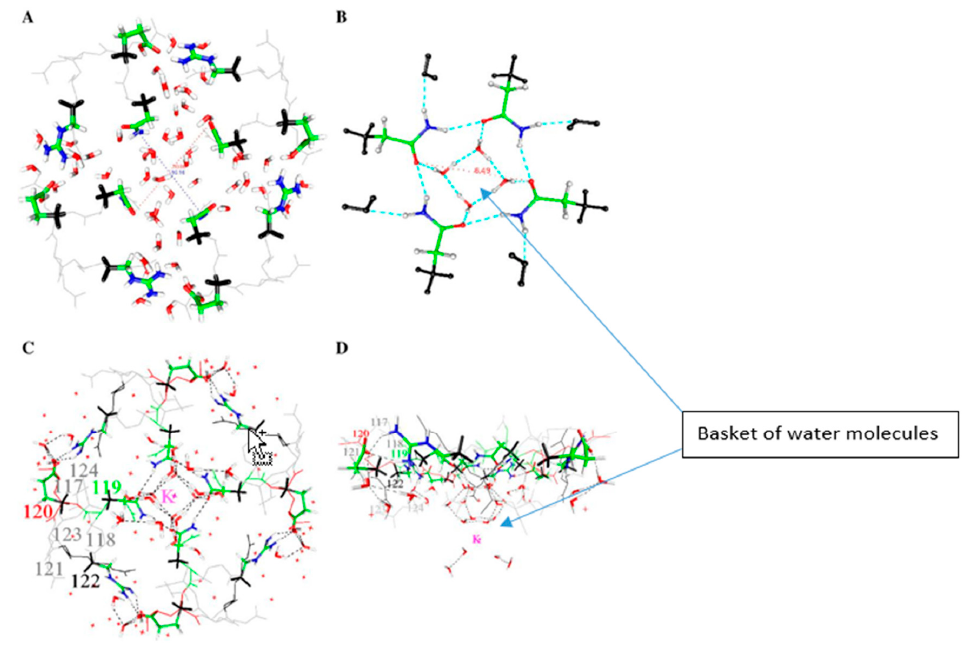
Figure 4. Four views of the KcsA gate: ( A ) Open (protonated) state of the KcsA channel, showing results of calculations on three amino acids from all four domains, plus water, optimized at HF/6-31G** level. Outer methyl groups are frozen. The distance between the two oxygen atoms of Q119 (a key amino acid, which may partially control the gate) is 10.9 Å on one diagonal, 10.2 Å on the other. ( B ) The closed state, Q119 only, plus the water; this calculation is done at B3LYP/6-311+G** level. Instead of 11 Å, the distance across is now only approximately 6 Å, not enough for a hydrated K + ion, even if the water molecules could exchange instead of blocking the channel. ( C , D ) The uncharged (closed) state of all three amino acids (2 orientations), plus the remainder of the structure, not present in the computation. In C, amino acids are numbered in the standard KcsA form. This figure is reproduced from Kariev, Znamenskiy, and Green [124].